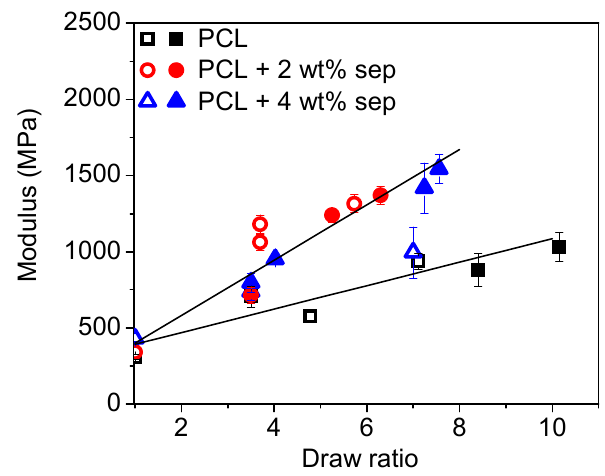
Figure 13. The elastic modulus as a function of pre-orientation corrected for total draw ratio. Open symbols correspond to samples cooled with open chill rolls, while closed symbols correspond to samples cooled with closed chill rolls.